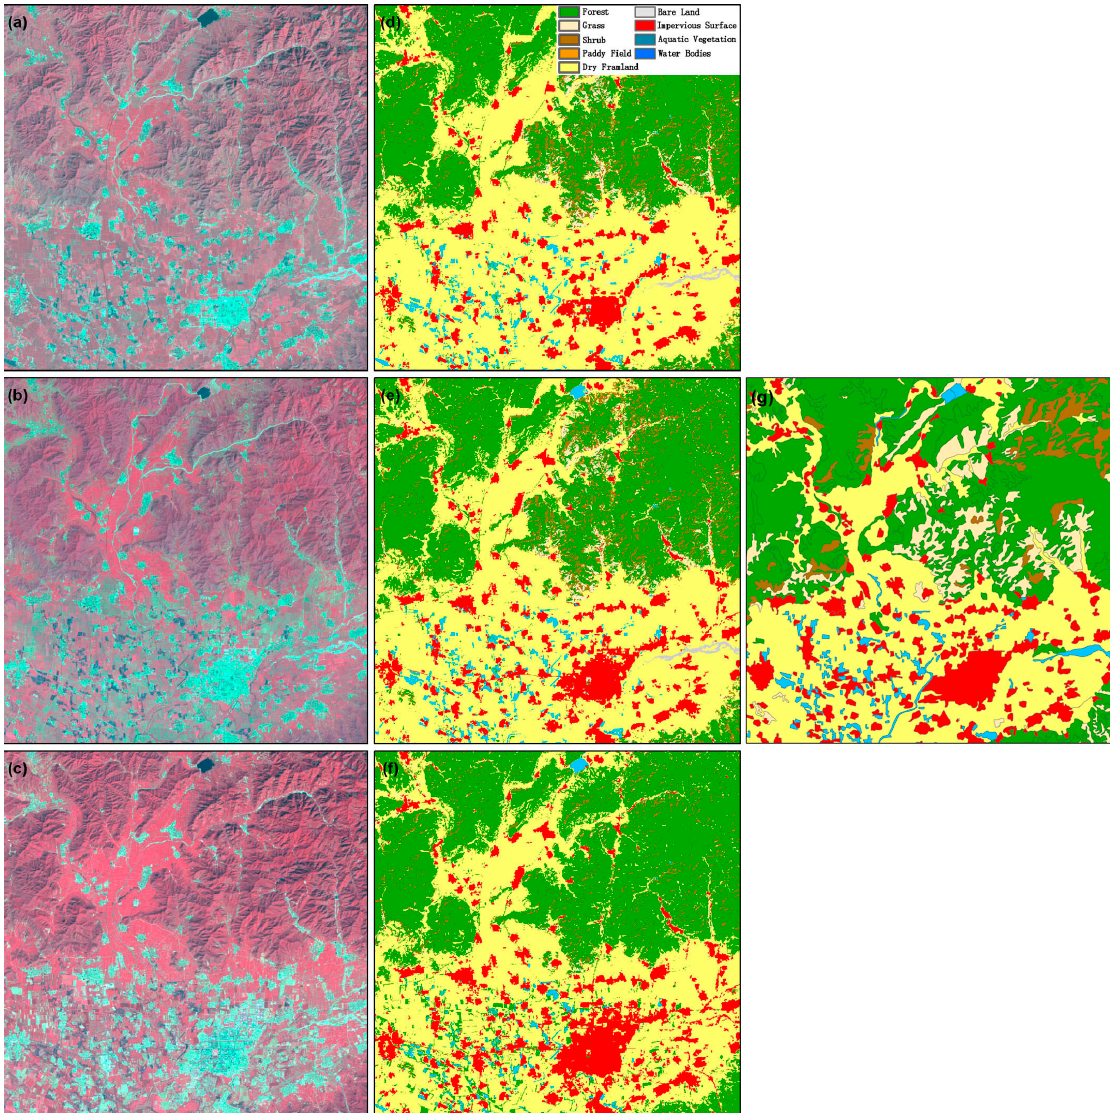
Figure 4. Details of the classifications of the sub-area in the JJT: ( a ) Landsat 5 TM sub-image at Path/Row 123/032 that was acquired on 7 September 1992; ( b ) Landsat 7 ETM+ sub-image that was acquired on 2 August 1999; ( c ) Landsat 5 TM sub-image that was acquired on 22 September 2009; ( d – f ) classification results for (a–c), respectively; and ( g ) China’s Land-Use/cover Datasets (CLUDs) in 2000.